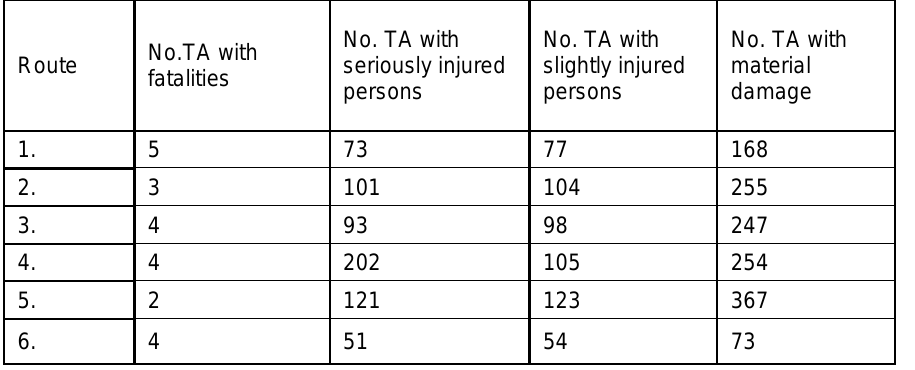
Table 2 – Route parameters in relation to the formed output